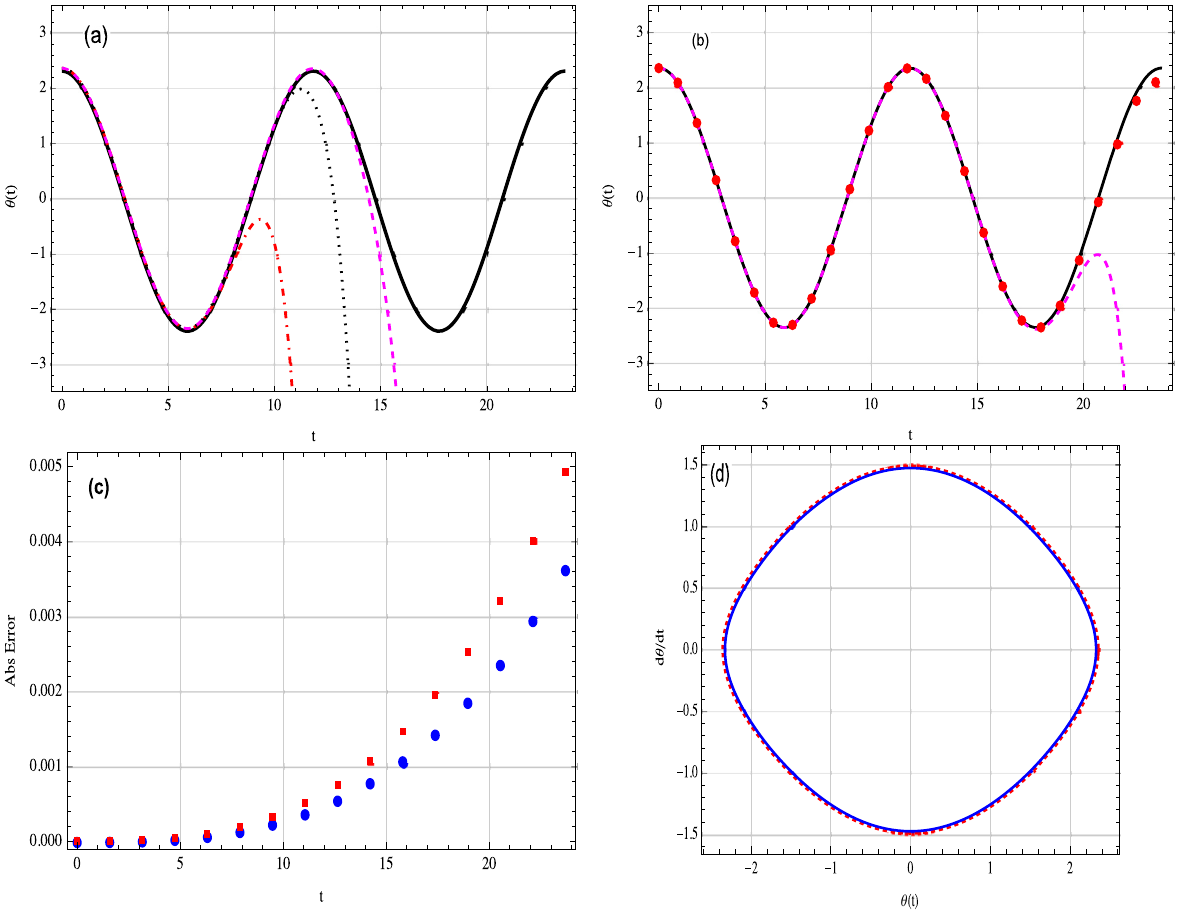
Figure 4: ( a ) Comparison of the MDM approximation θ t π , 0, 3 4, 0 12 ( ) / ( dash - dotted line ) , θ t π , 0, 3 4, 0 16 ( ) / ( dotted line ) , θ t π , 0, 3 4, 0 18 ( ) / ( dashed line ) and the exact solution ( solid line ) . ( b ) The exact solution ( solid line ) , the 25th - order MDM numeric solution θ h 0.3 = ( dashed line ) , and the 30th - order MDM numeric solution θ 30 ⟨ ⟩ with the exact solution ( dots ) and the 30th - order ADM numeric solution ( squares ) , respectively. ( d ) Phase plane diagram, exact ( solid θ k 30 ⟨ ⟩ approximation ( dot ) for Example line ) , and θ k